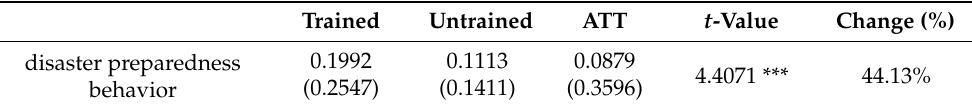
Table 5. Impacts of training on disaster-preparedness